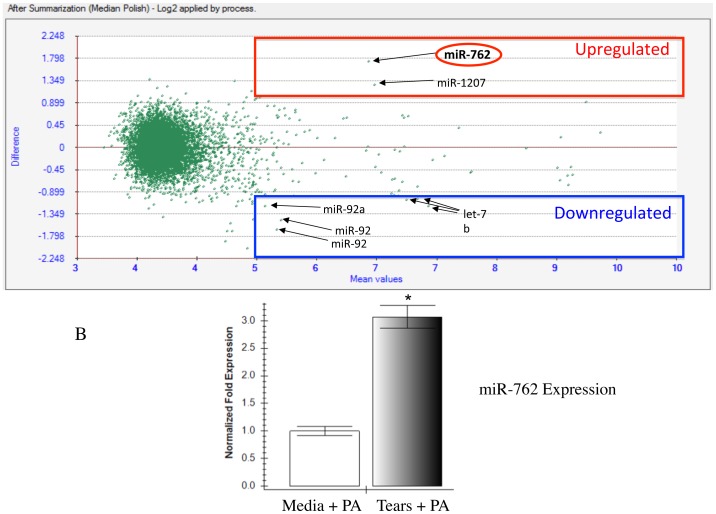
Upregulation of miR-762 in human corneal epithelial cells in response to human tear fluid and P. aeruginosa antigens.a Microarray analysis of human corneal epithelial microRNA expression in response to P. aeruginosa antigens (3 h incubation) with and without prior exposure to human tear fluid for 16 h (see Material and Methods). Red and blue boxes indicate microRNAs which were up- or down-regulated respectively by 2-fold or more in response to bacterial antigens with prior tear fluid exposure (expressed relative to bacterial antigen challenge without prior tear exposure). The y-axis is shown as log2 (comparing tear fluid + antigens versus media + antigens) with a value of 1 or -1 meaning that the test group was up- or down-regulated respectively by 2 fold. The x-axis shows mean values of the test and control and represent raw data values from the microarray. Only values greater than 5 were considered. Those below 5 were below detection (i.e. considered background). Since there were multiple data points between 3–4 and 6–7 the software generated the figure to distribute these data points along the x-axis. PA  =  P. aeruginosa antigens, Media  =  High Calcium KGM-2. Eight wells of hTCEpi (grown in 96-well plates) were pooled to obtain sufficient RNA for each treatment group, b Real-time PCR confirmed a ∼3-fold upregulation of miR-762 in tear-treated epithelial cells in response to antigenic challenge (* Significant difference vs. control, t-Test).